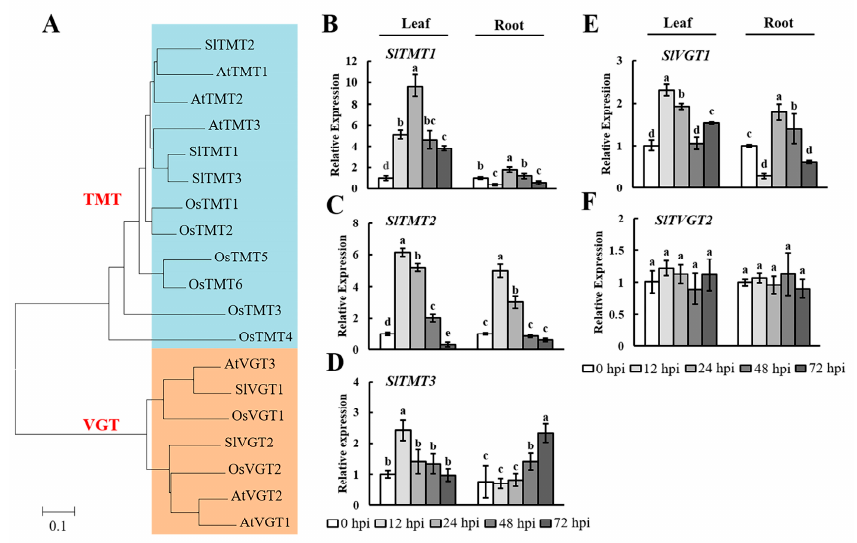
Figure 5. Expression levels of SlTMTs and SlVGTs in tomato leaves and roots after RKN infection. ( A ) Phylogenetic analysis of TMT and VGT proteins from Arabidopsis thaliana ( At ), Oryza sativa ( Os ), and Solanum lycopersicum ( Sl ). A phylogenetic tree was constructed using the neighbor-joining method with 1000 bootstrap replications (TMT: blue part; VGT: yellow part). The accession numbers are listed in Supplementary Table S1. qRT-PCR was used to quantify SlTMT ; ( B – D ) and SlVGT ; ( E , F ) expression at 0, 12, 24, 48, and 72 h postinoculation (hpi) with Meloidogyne incognita . Three biological replicates were analyzed and three technical repeats were performed per sample. Error bars indicate the SD between biological repeats ( n = 3). Different letters indicate significant differences ( p < 0.05).